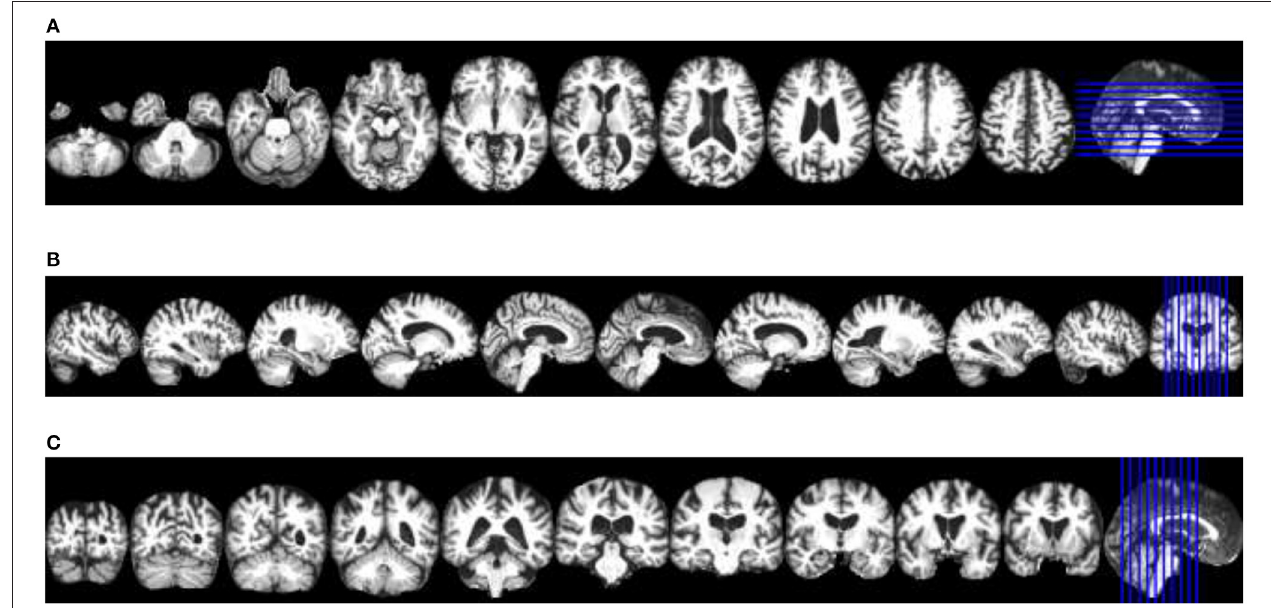
FIGURE 3 | Slices with different views. (A) Axial view, (B) Sagittal view, (C) Coronal view.